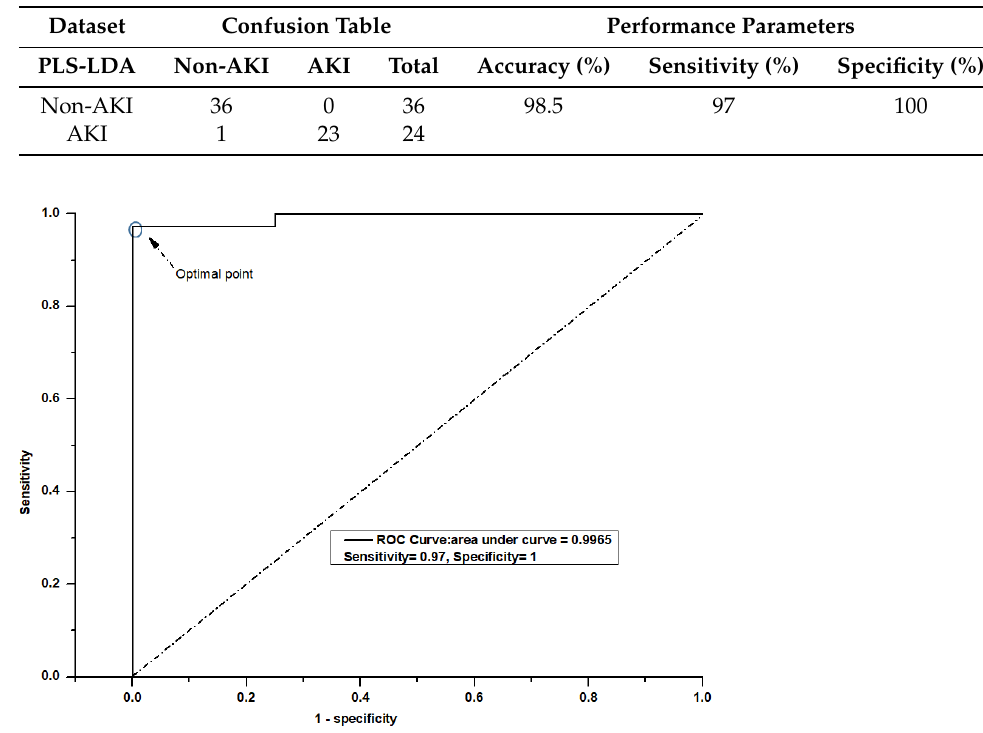
Table 2. Test set misclassifications and performance tables of the PLS-LDA model.